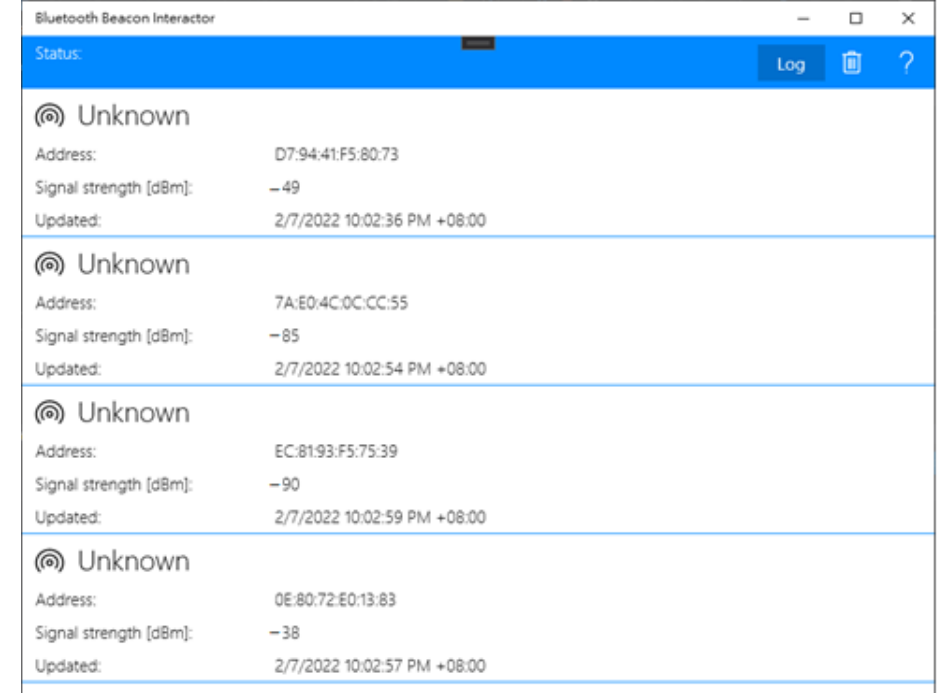
Figure 1. User Interface of Bluetooth signal captured App.